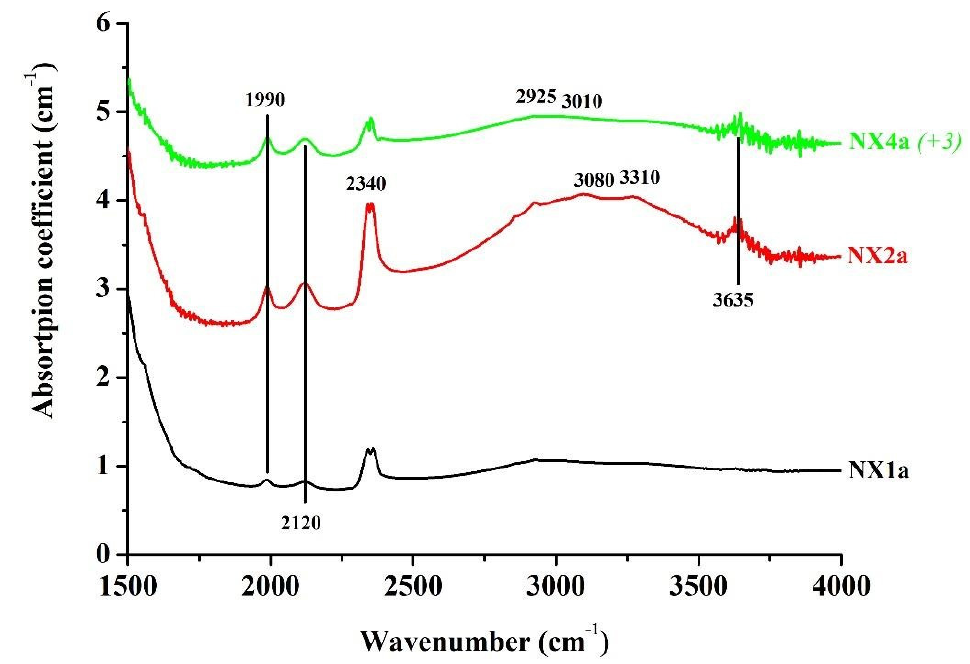
Figure 6. FTIR spectra of the samples NX1a (black trace), NX2a (red trace) and NX4a (green trace). The green spectrum is shifted vertically (value in parenthesis) for clarity.